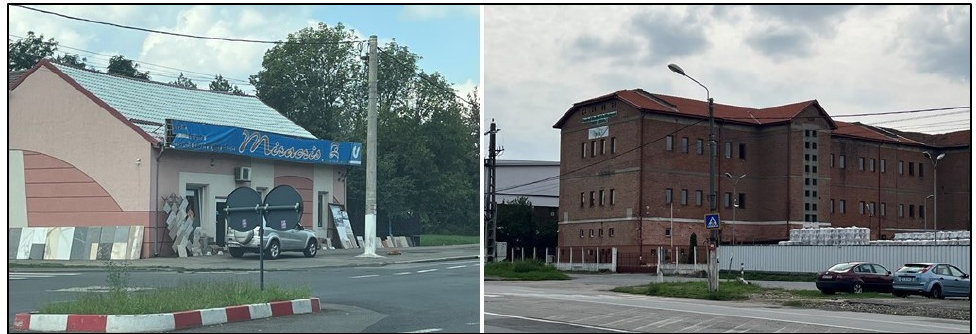
Figure 8. The Headquarter of FED Lugoj (photo taken by author, July